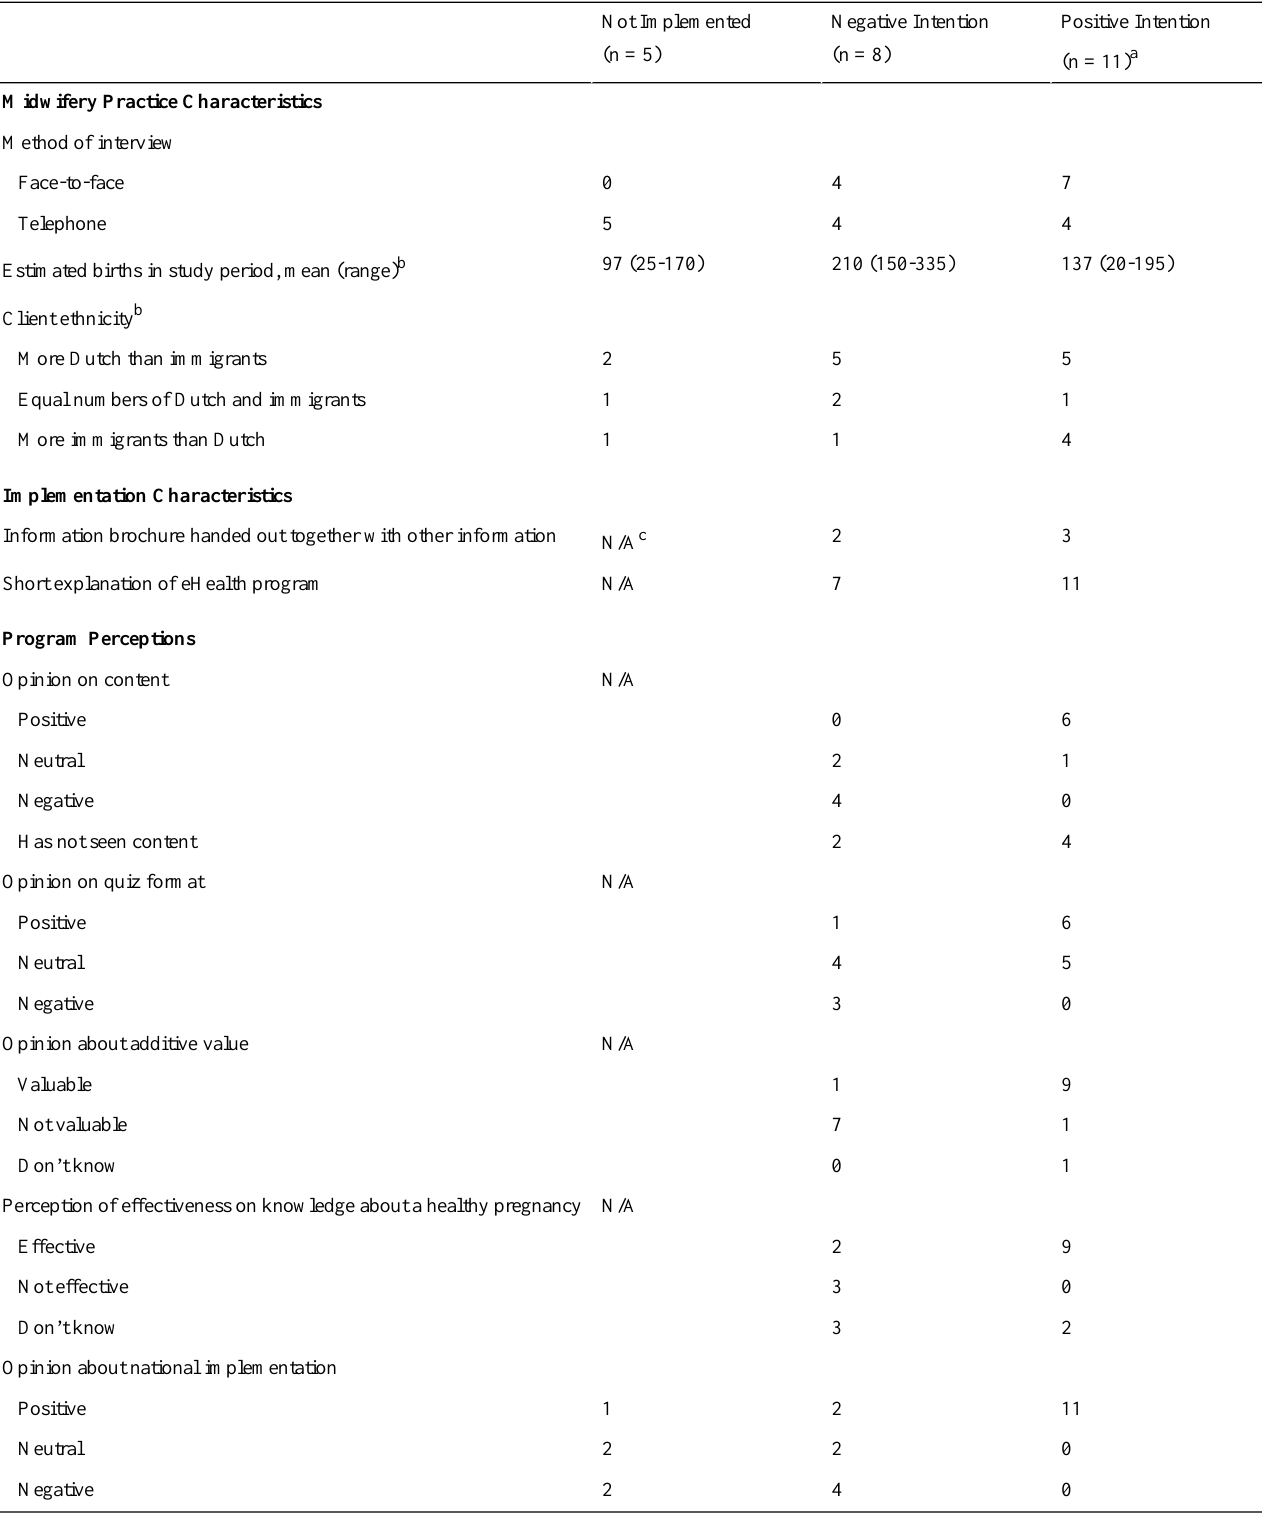
Table 1. Practice characteristics, program implementation characteristics, and program perceptions of midwifery practices, stratified by the intention to integrate the eHealth program into standard midwifery care after the study